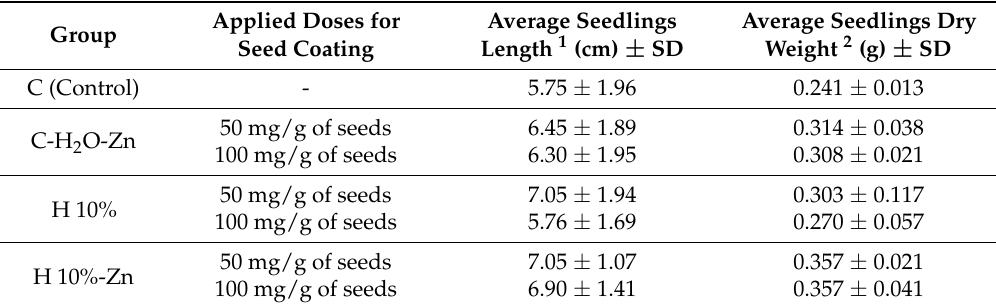
Table 3. The effect of the dose of algal homogenate (H) on the length and weight of the seedlings ( N =